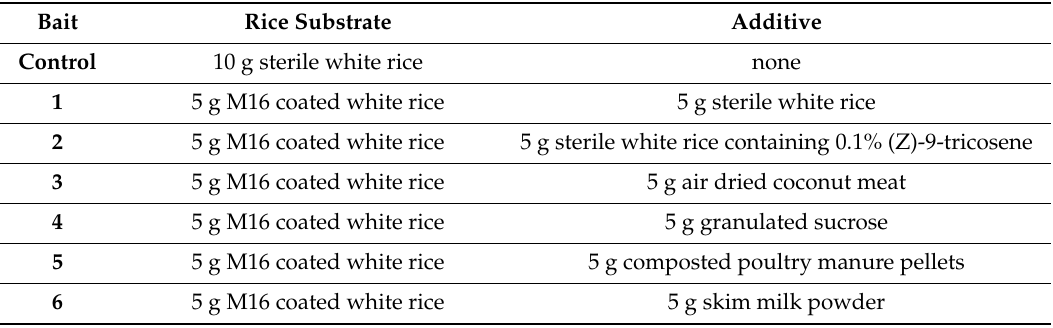
Table 2. Compositionoftrialbaitformulationscontaining Metarhiziumanisopliae M16andvariousadditives. Bait Rice